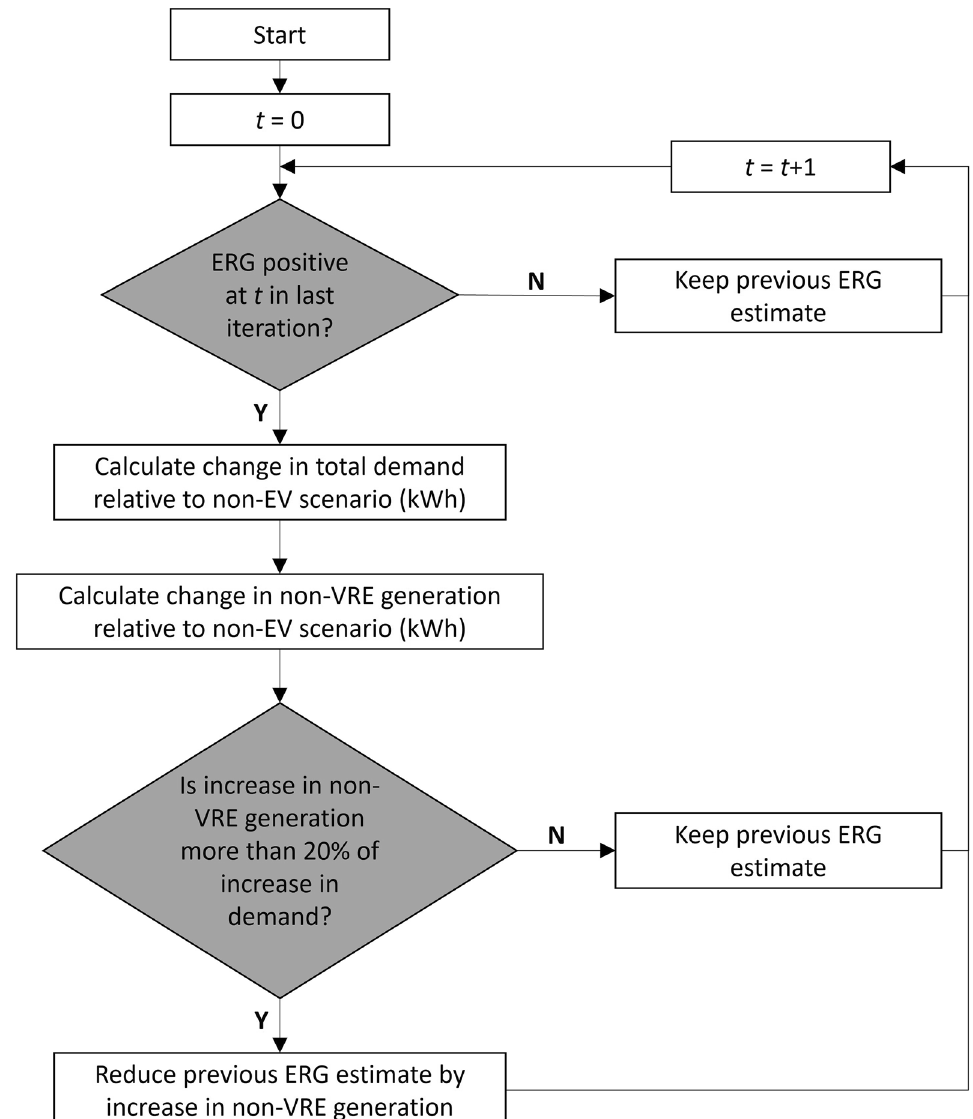
Fig. 3 Flowchart for iterative procedure linking SILVER with charging model to ensure UCC only uses renewable generation